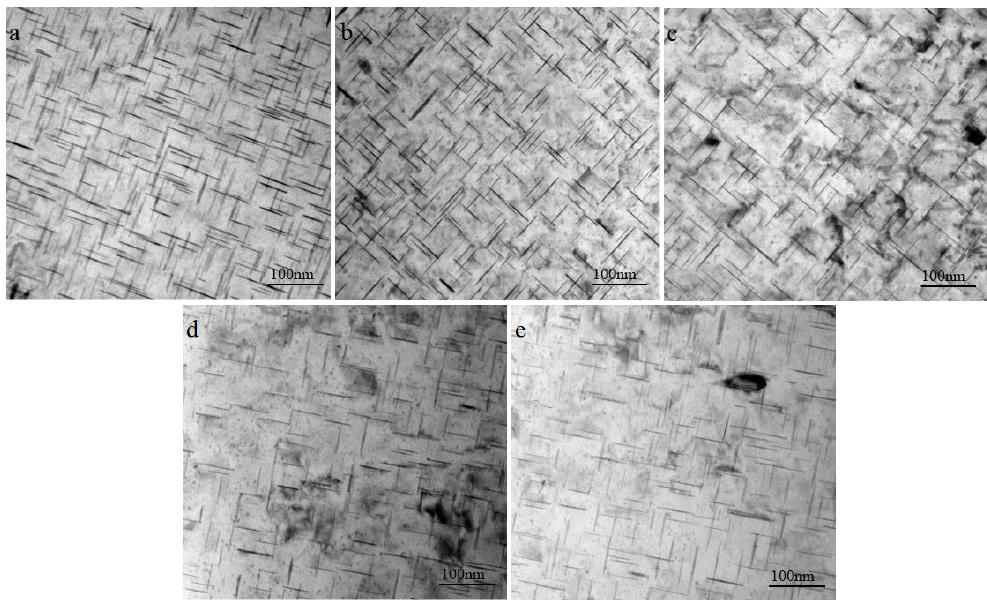
Figure 8. Morphology of the strengthened θ ， phases of different heat input deposits at the peak aging state. ( a ) 30 J/mm; ( b ) 60 J/mm; ( c ) 90 J/mm; ( d ) 120 J/mm; ( e ) 150 J/mm.